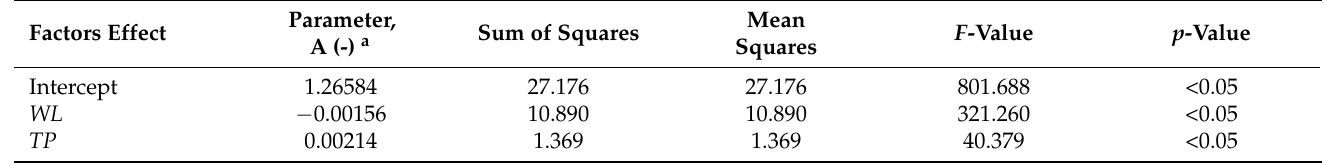
Table 8. Absorbance parameter estimates and statistical evaluation.